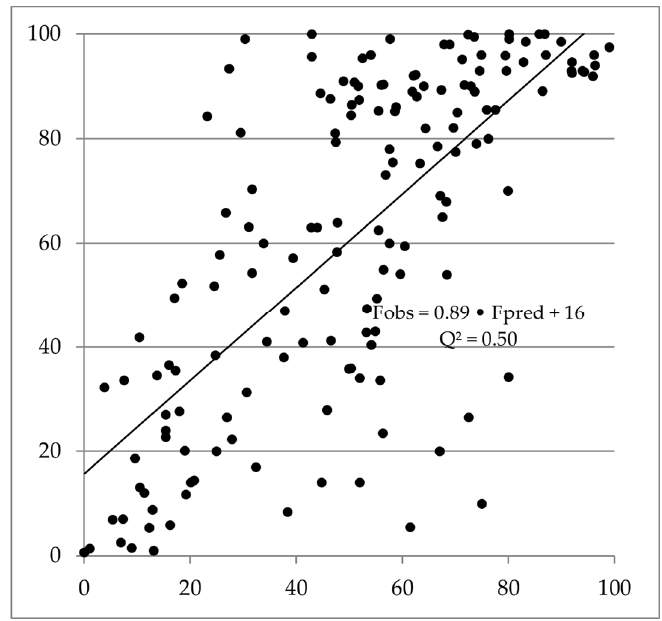
Figure 1. In silico predicted vs. observed human clinical oral bioavailability for 156 compounds. The R 2 -estimates between animal and human F obs were lower: 0.40 for mice ( n = 28), 0.21 for rats ( n = 101) and 0.31 for dogs ( n = 106) (Table 1; Figure 2; Supplement Figure S1). Corresponding Q 2 -estimates for head-to-head (same compounds) in silico predictions of F in humans were 0.54, 0.61 and 0.48, respectively. Combining data from the three animal species did not enhance the R 2 (0.23; n = 26).